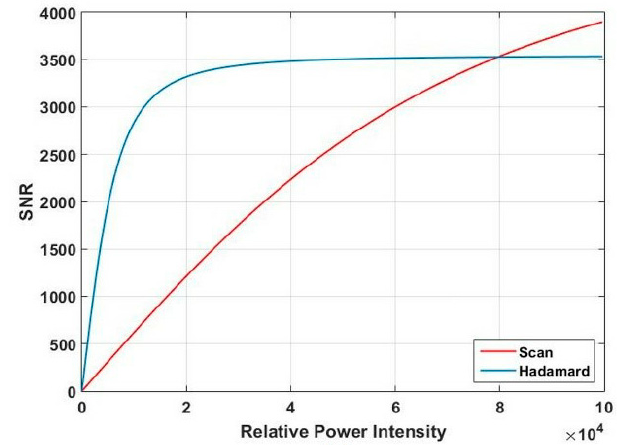
Figure 8. Signal-to-noise ratio (SNR) of two scan methods for light source energy dropping off in proportion.